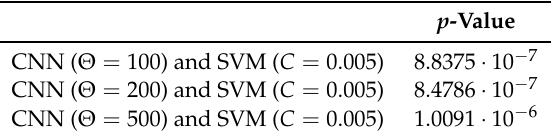
Table 8. ANOVA comparison between CNNs and SVMs providing the second better average predictive accuracy (equal to